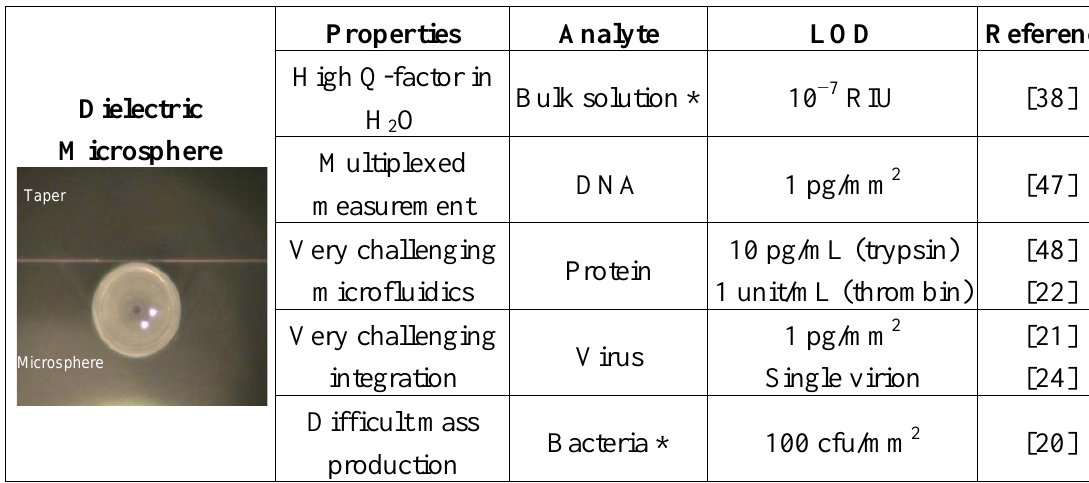
Table 1. A summary of some label-free WGMR biosensing results; the properties of the transducer, the target analyte, the reported LOD and the reference are indicated. (*non-specific